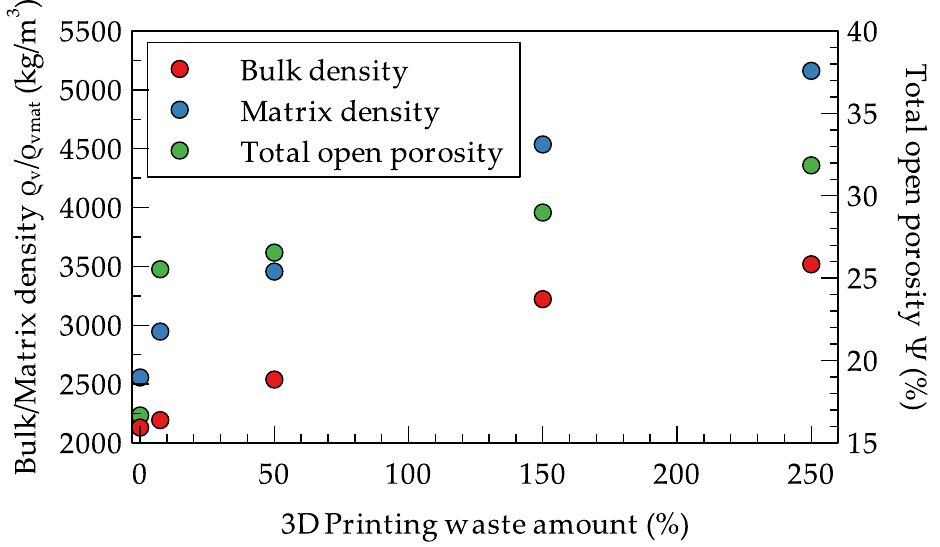
Figure 10. Bulk/matrix density, total open porosity.